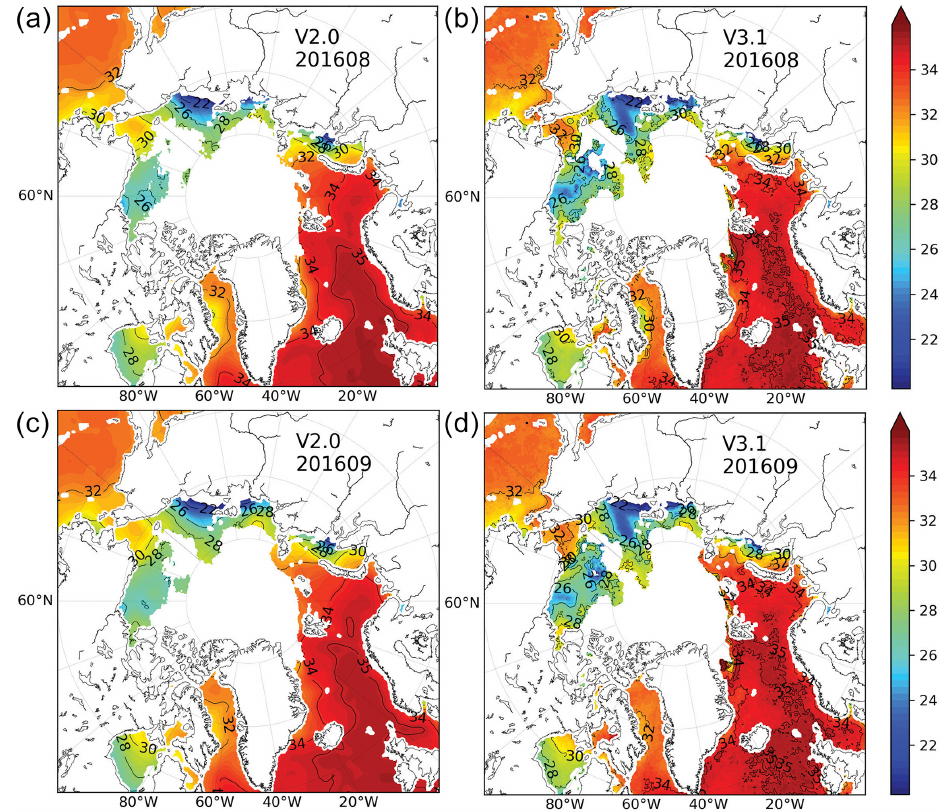
Figure 1. Monthly SSS of August (a,b) and September (c,d) in 2016 from SMOS products of BEC V2.0 (a,c) and V3.1 (b,d) . Note: the solid isolines of SSS are 22, 26, 28, 30, 32, 34, and 35psu.